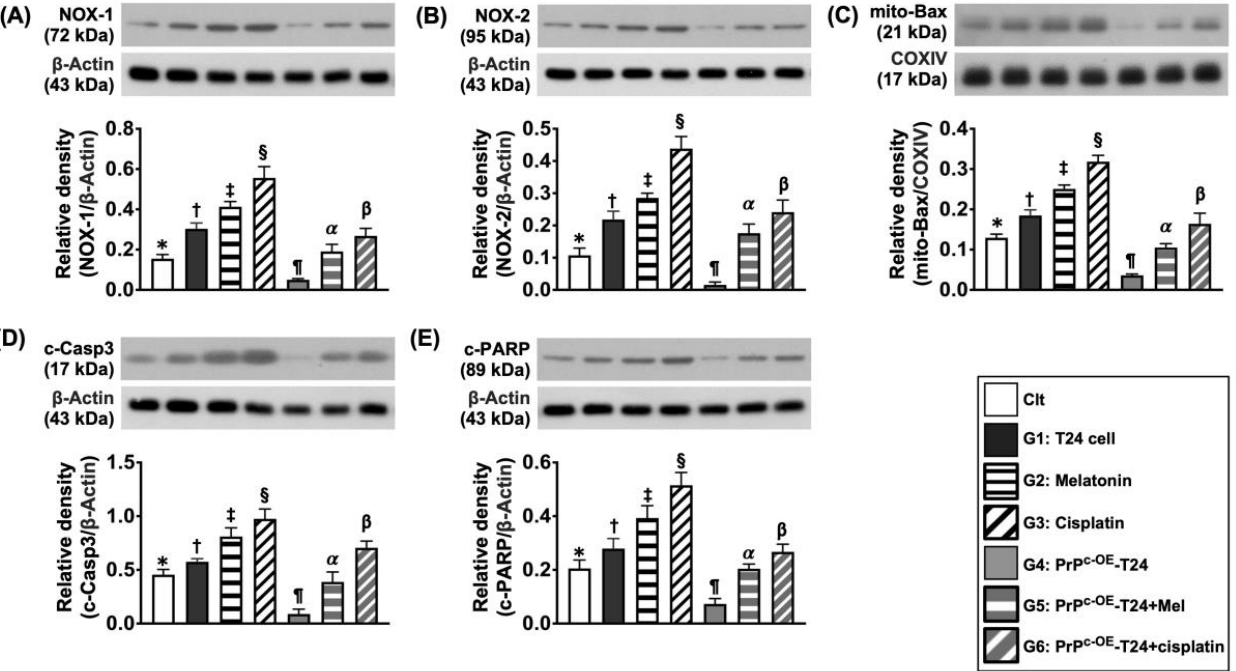
Figure 7. Protein levels of oxidative stress and apoptosis in different situations. ( A ) Protein level of NOX-1: (1) * vs. different symbols (†, ‡, and §) and (2) ¶ vs. different symbols ( α and β ), all p values < 0.0001. ( B ) Protein level of NOX-2: (1) * vs. different symbols (†, ‡, and §) and (2) ¶ vs. different symbols ( α and β ), all p values <0.0001. ( C ) Protein level of mitochondrial Bax (mit-Bax): (1) * vs. different symbols (†, ‡, and §) and (2) ¶ vs. different symbols ( α and β ), all p values <0.0001. ( D ) Protein level of cleaved (c) caspase 3 (c-Casp3): (1) * vs. different symbols (†, ‡, and §) and (2) ¶ vs. different symbols ( α and β ), all p values < 0.0001. ( E ) Protein expression of c-PARP: (1) * vs. different symbols (†, ‡, and §) and (2) ¶ vs. different symbols ( α and β ), all p values <0.0001. n = 6 for each group. Control (Clt) = V-HUC-1; G1 = T24 only; G2 = melatonin (Mel); G3 = cisplatin; G4 = PrP C overexpression in T24 cells (i.e., PrP C-OE -T24); G5 = PrP C-OE -T24 cells + Mel (100 uM treated for 24 h); G6 = PrP C-OE -T24 cells + cisplatin (6.0 uM treated for 24